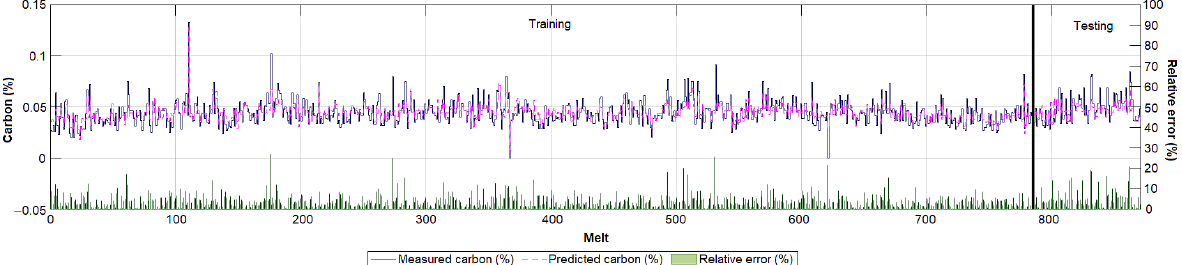
Figure 15. Prediction of endpoint carbon concentration in melt by piecewise-linear MARS model.